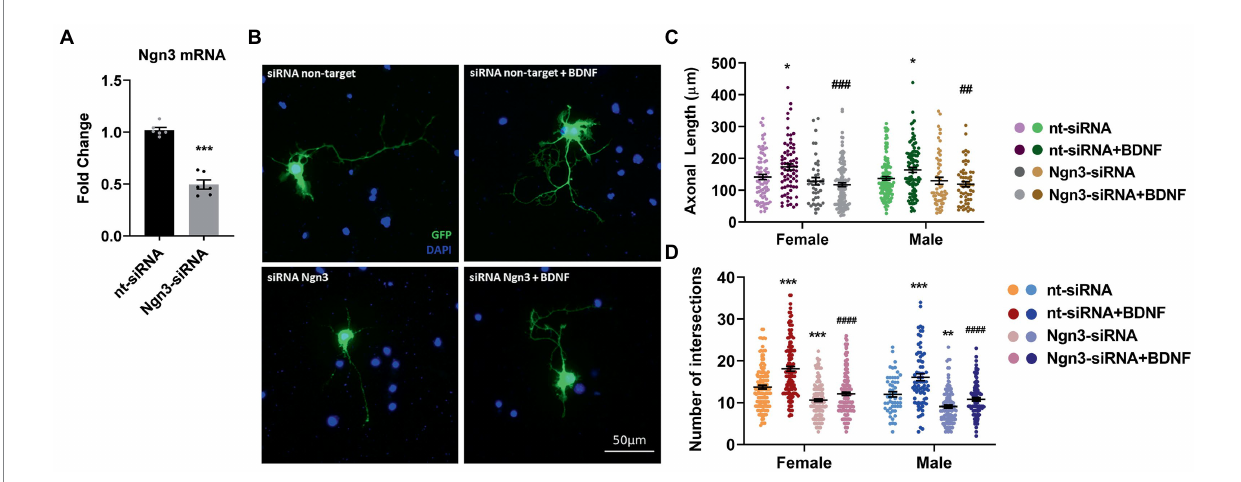
FIGURE 7 Knocking-down Ngn3 blocks the BDNF effect on the hippocampal neuron development in cultures. (A) Downregulation of Ngn3 mRNA levels in electroporated cultures with two specific siRNAs for this gene; N = 5. Graphs represent the mean ± SEM; Unpaired t -test: *** p < 0.001. (B) Representative example of neurons immunostained with Green Fluorescent Protein (GFP, green) and DAPI (blue). Electroporated neurons with non-target siRNA are shown in the panel above and neurons targeted with Ngn3 siRNA are displayed in the panel below. (C) Quantitative analysis of axonal length and (D) complexity of the dendritic arbor (number of intersections of dendrites with the circles in the Sholl analysis) of sexed cultures at 3 DIV with non- target or Ngn3 siRNA. Neurons quantified (50–100) are at least from four independent experiments. Data represent the mean ± SEM; two-way ANOVA with Tukey’s multiple comparisons: * p < 0.05, ** p < 0.01, and *** p < 0.001 vs. nt-siRNA group; ## p < 0.01, ### p < 0.001, and #### p < 0.0001 vs. nt-siRNA + BDNF